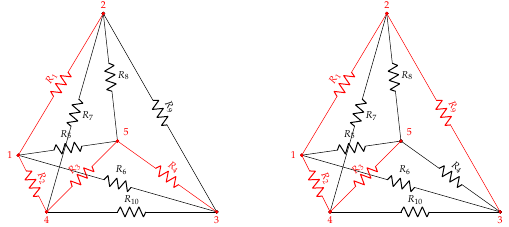
Figure 7. Resistive grid configurations with alternative complete paths using a different starting